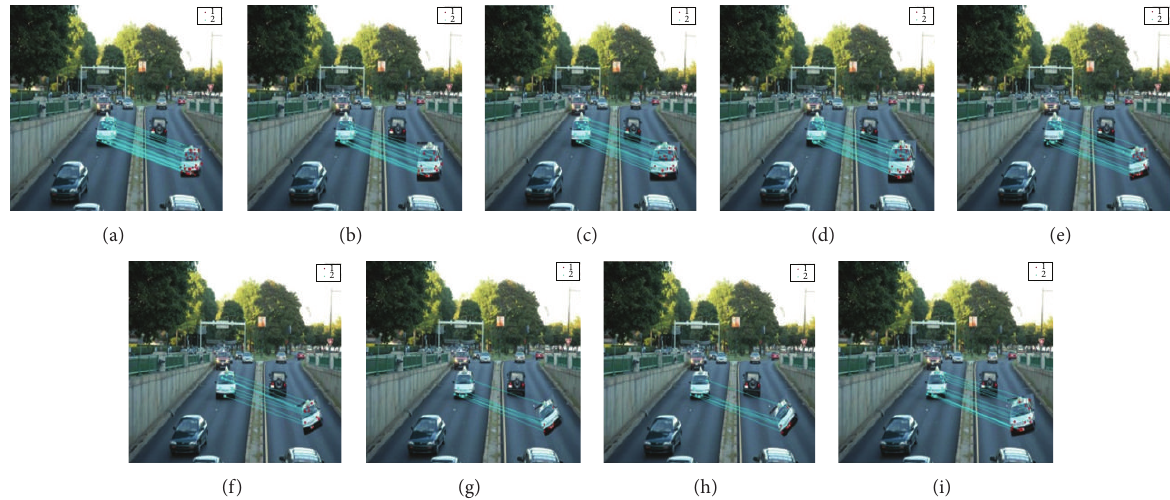
Figure 4: Copy paste detection results in the presence of 10 different rotation and scaling attacks applied on the image.